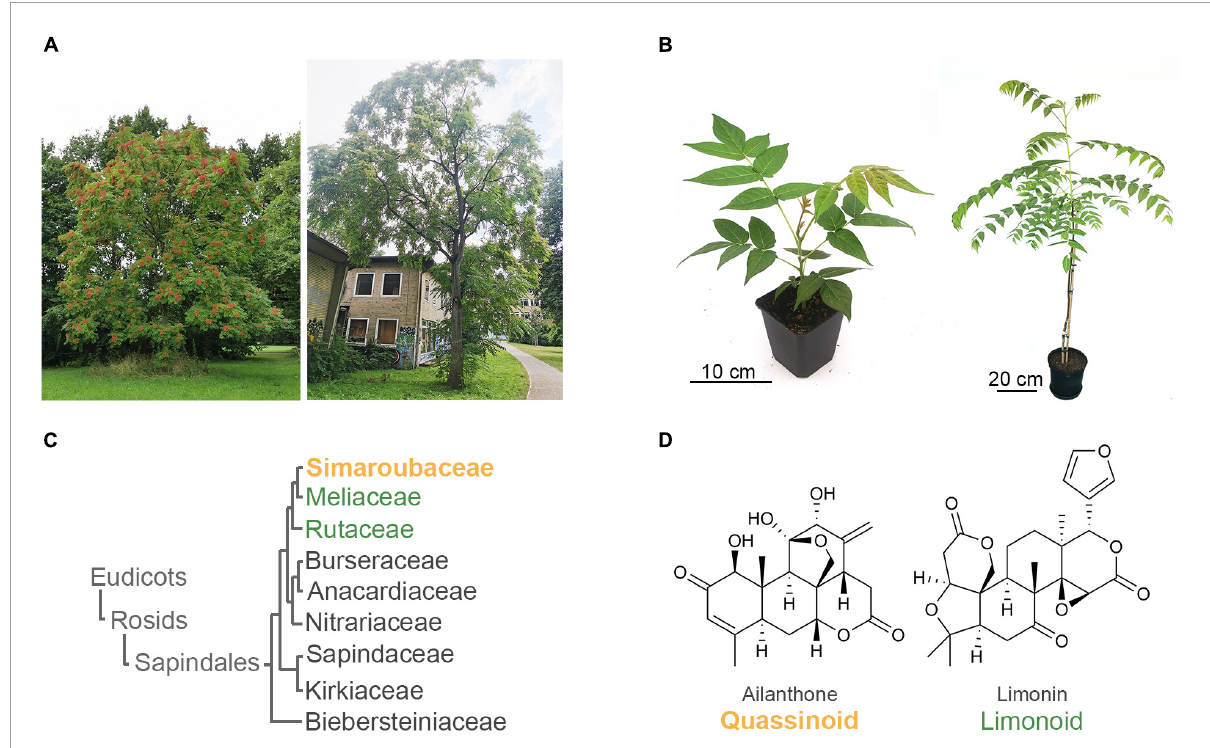
FIGURE1 The invasive tree of heaven ( Ailanthus altissima , Simaroubaceae) produces allelochemical triterpenoids called quassinoids with structural similarities to limonoids, which occur in the sister families Meliaceae and Rutaceae of the order Sapindales. (A) Tree of heaven in Hannover, Germany. (B) 8-week-old seedling and 3-year-old tree growing in the laboratory. (C) Relationship of families in the order Sapindales (The Angiosperm Phylogeny Group et al., 2016). (D) Structures of the representative quassinoid ailanthone and limonoid